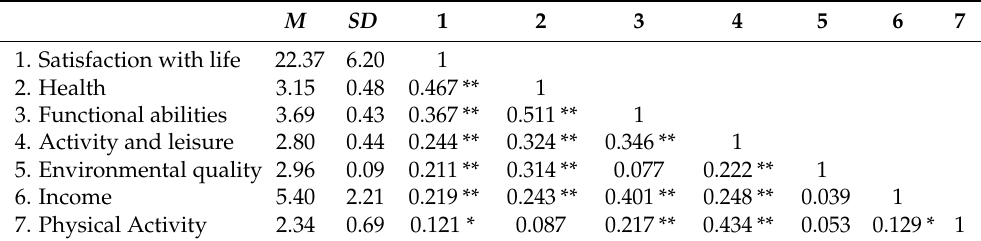
Table 1. Mean, standard deviation and Spearman correlations of the variables of satisfaction with life, quality of life and physical activity of the participants. M SD 1 2